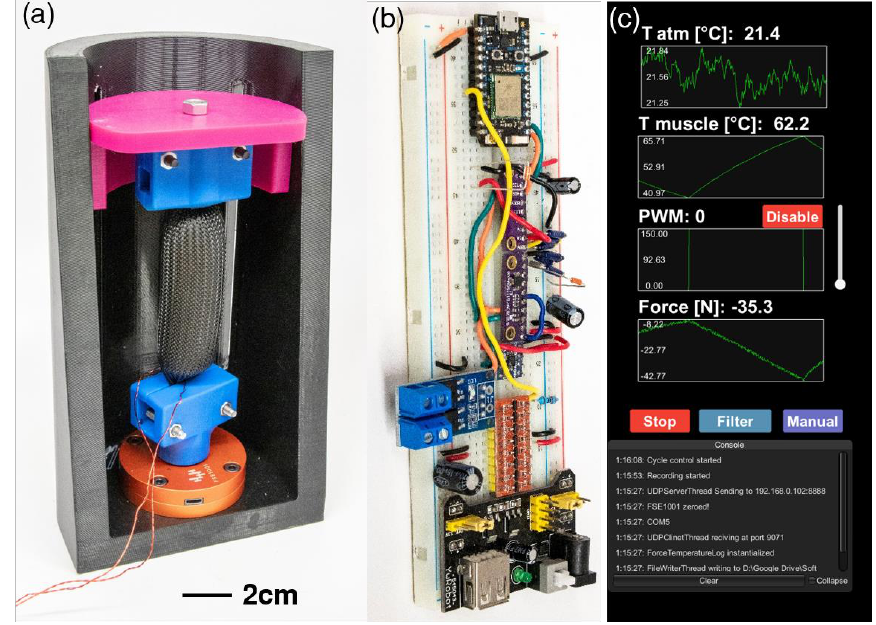
Figure A1. The multi-cyclic actuation test unit ( a ), its electrical ( b ), and software ( c ) components.